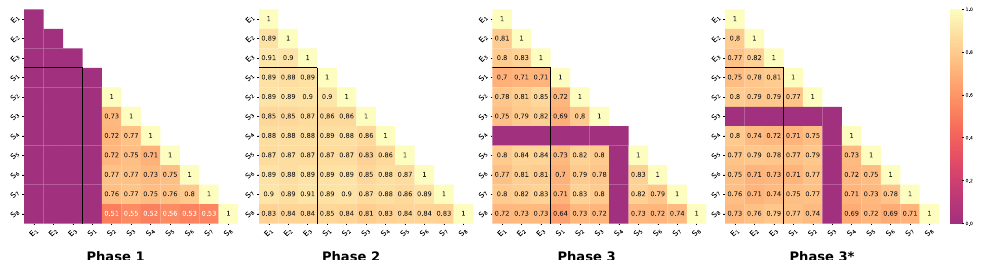
Figure 8. Cohen’s kappa pairwise matrix between students (S) and experts (E) for 4 phases of marking: ( Phase 1 ): shared image from the Good group, prior to the creation of the annotation protocol, the markup was independent—participants did not confer, ¯ κ = 0.69 ± 0.10. ( Phase 2 ): shared image from the Good group, immediately after creation of the annotation protocol, participants conferred, ¯ κ = 0.87 ± 0.02. ( Phase 3 ): shared hidden image from the Good group during the labelling process, independent mark-up, ¯ κ = 0.77 ± 0.05. ( Phase 3* ): the same conditions as in Phase 3, but with a hidden image from the Different group, which was more difficult to analyse, ¯ κ = 0.75 ± 0.03. Purple cells without text show that the image was not marked by a particular member of the annotation group. The solid black line divides student–student, expert–expert, and student–expert